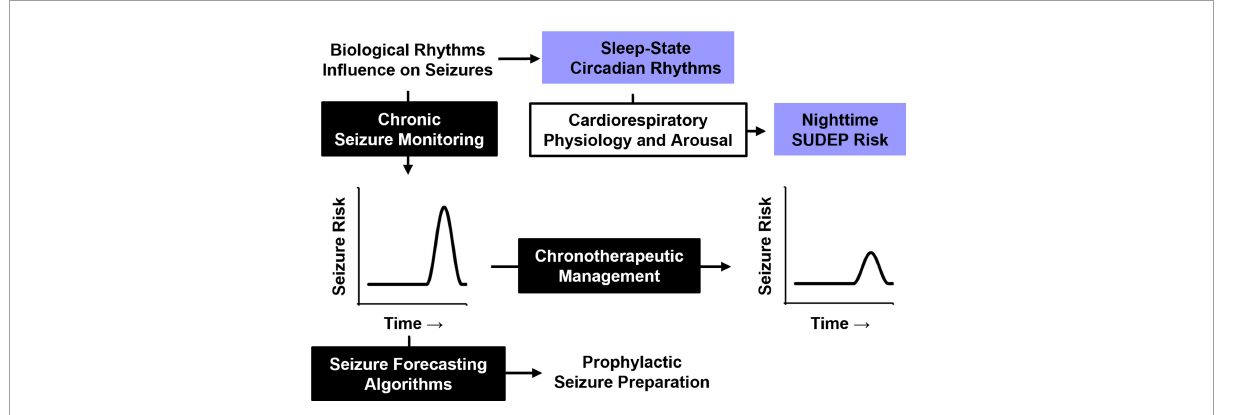
FIGURE6 Influence of biological rhythms on seizure timing and SUDEP. A better understanding of how biological rhythms influence seizure timing may be used for future epilepsy management. Periodic seizure risk could be used to forecast future seizures and prepare for them in advance or be used to guide chronotherapeutic medication strategies for at-risk patients. Understanding how nighttime physiology, particularly sleep and circadian rhythms, influence cardiorespiratory and arousal function will likely improve our understanding of SUDEP